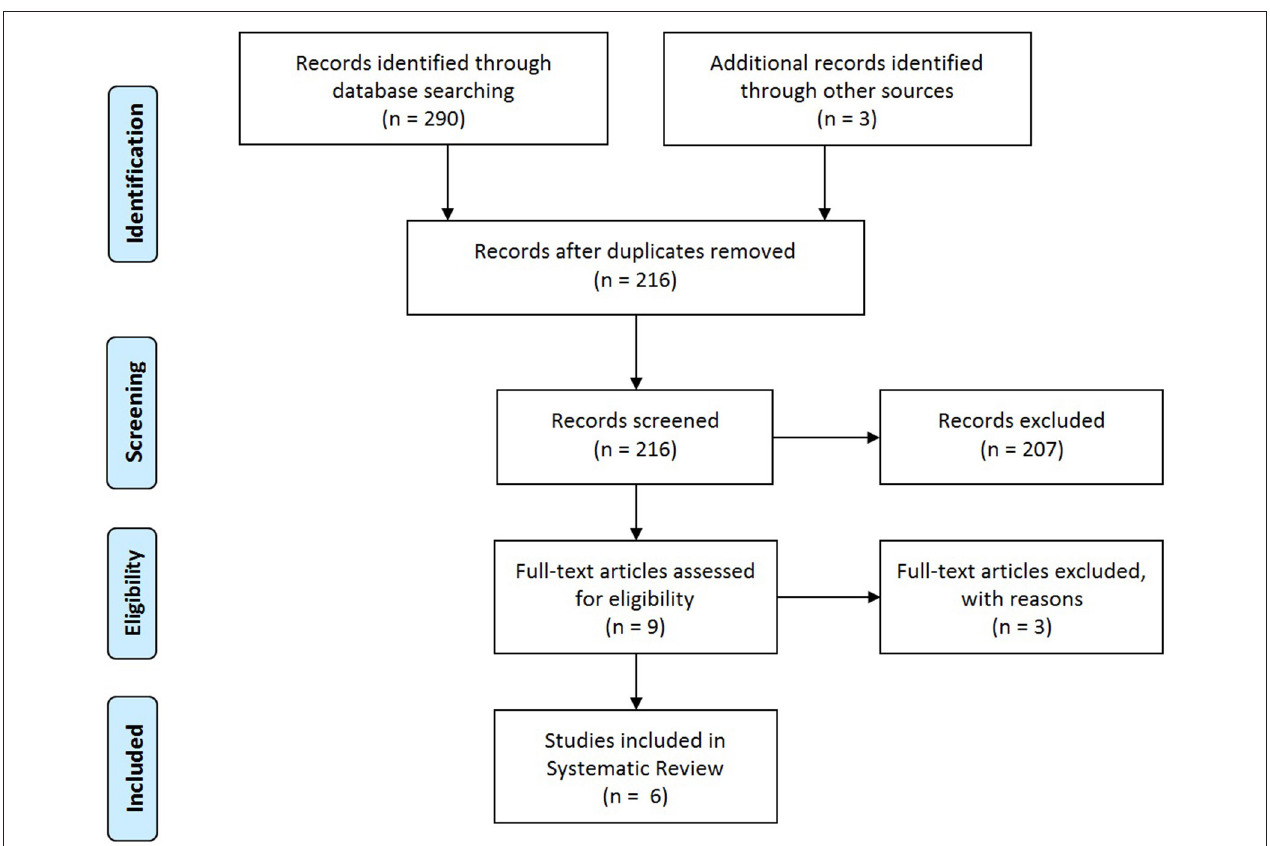
FIGURE 1 | PRISMA flow diagram; adapted from Moher et al.